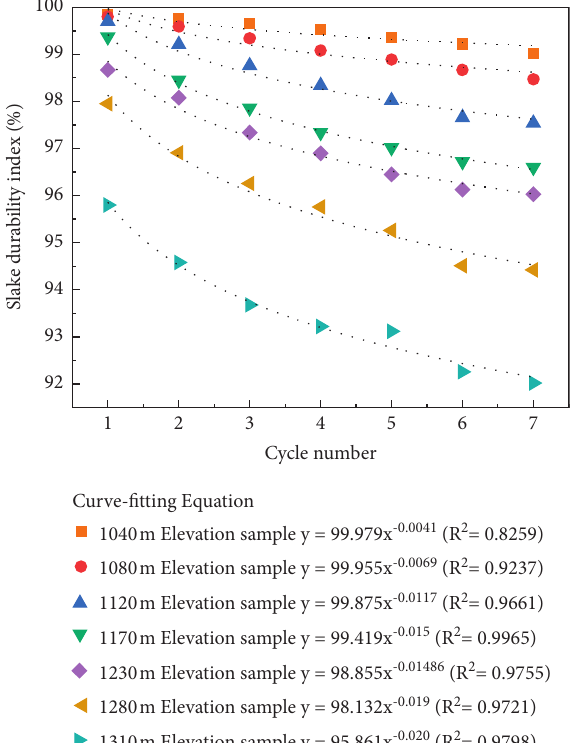
Figure 5: Relationship curves between rock collapse resistance index and cycle times at different